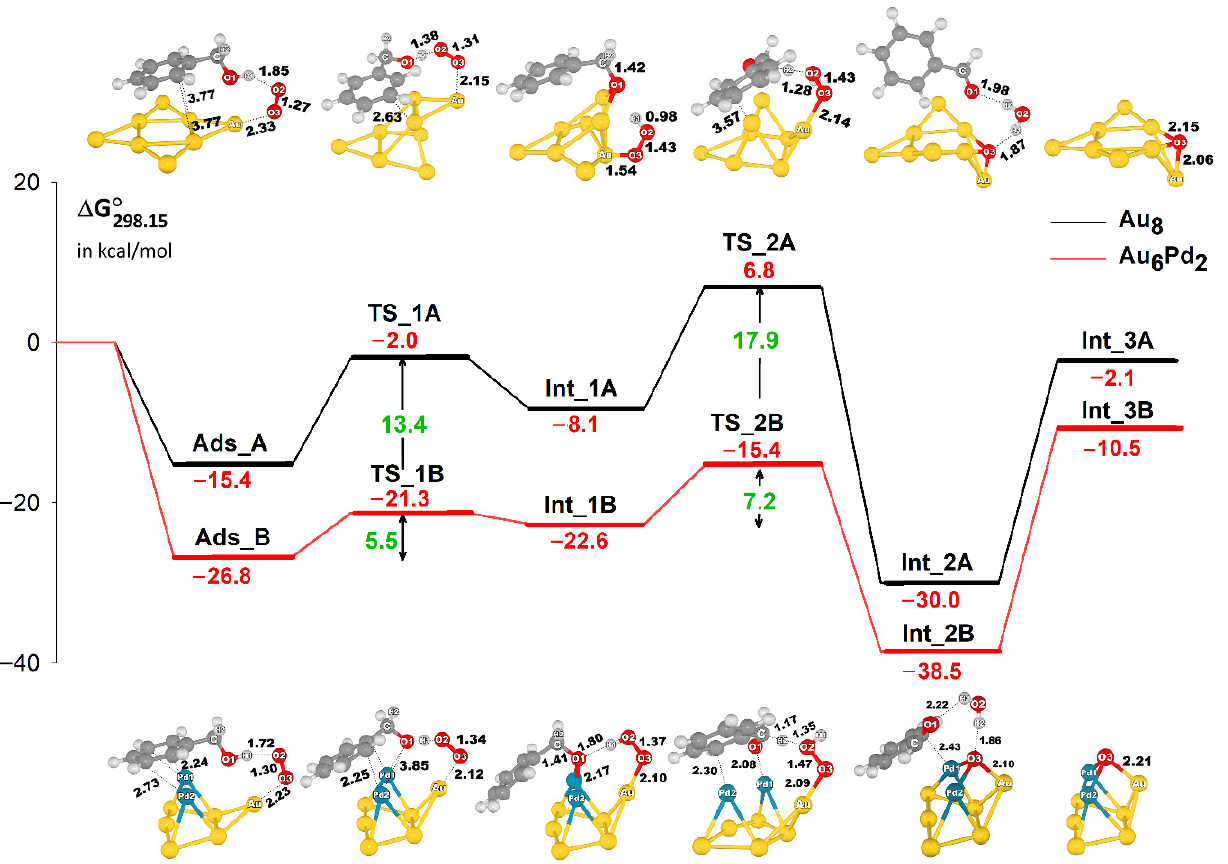
Figure 5. Calculated energy profile and optimized structures for the aerobic oxidation of benzyl alcohol over Au 8 and Au 6 Pd 2 generating benzaldehyde and H 2 O. All energy values are shown in kcal/mol and the distances are given in Å.